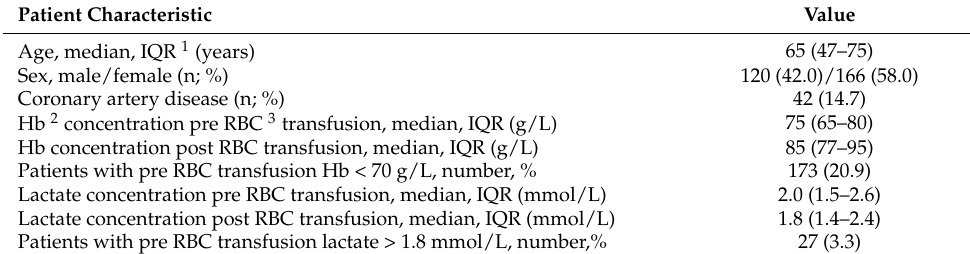
Table 3. Characteristics of patients transfused with red blood cell units.